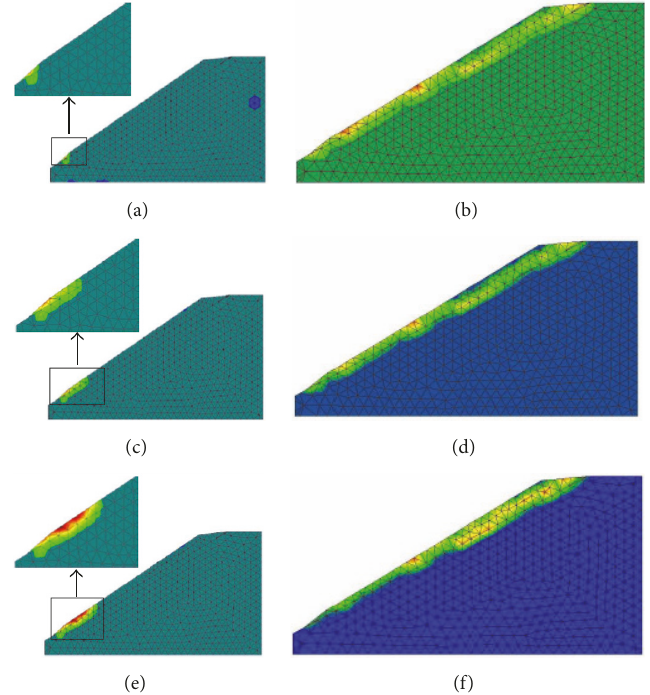
Figure 16: Maximum shear strain clouds of the deposited body: improved model after (a) 10,000, (c) 20,000, and (e) 30,000 time steps; unmodified model after (b) 10,000, (d) 20,000, and (f) 30,000 time steps.